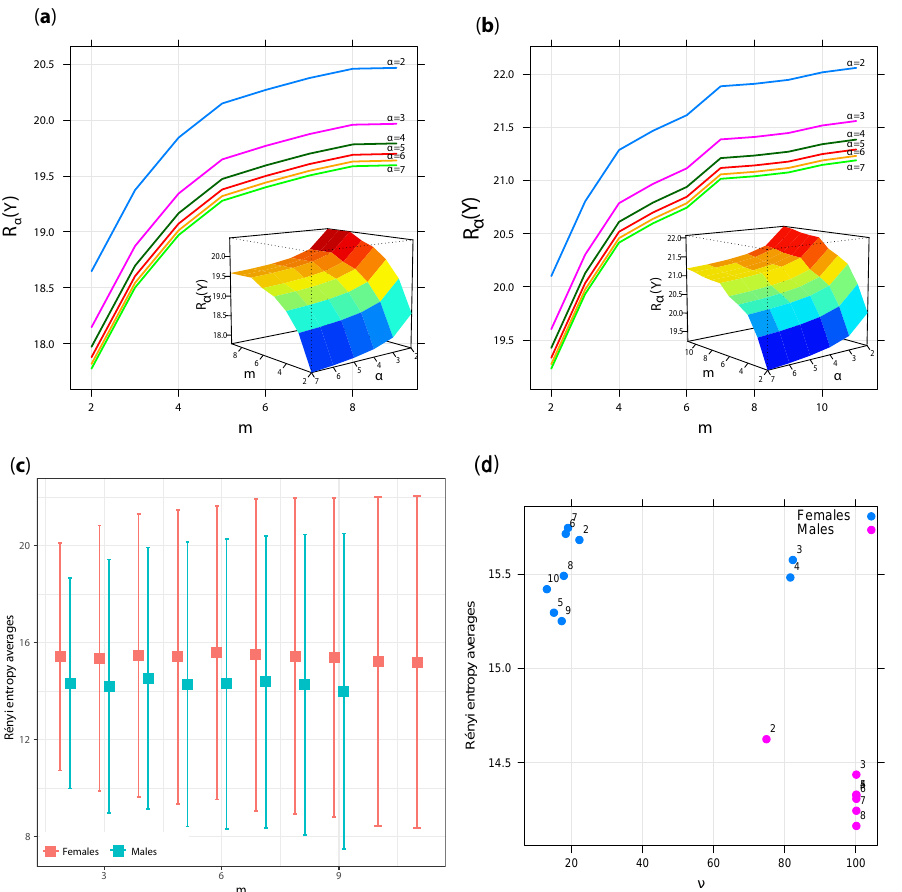
Figure 2. Upper bounds for Rényi entropies based on finite mixture of skew- t (FMST) distribution [ R α ( Y ) ] by number of components ( m ), for ( a ) males and ( b ) females, respectively. 3d-subplots correspond to R α ( Y ) versus m and α . Panel ( c ) shows the whisker plots of lower and upper bounds for Rényi entropies based on FMST distribution, and their respective averages by gender and number of components m . Panel ( d ) shows a dispersion plot between R α ( Y ) and ν by gender, where the number of each point corresponds to m